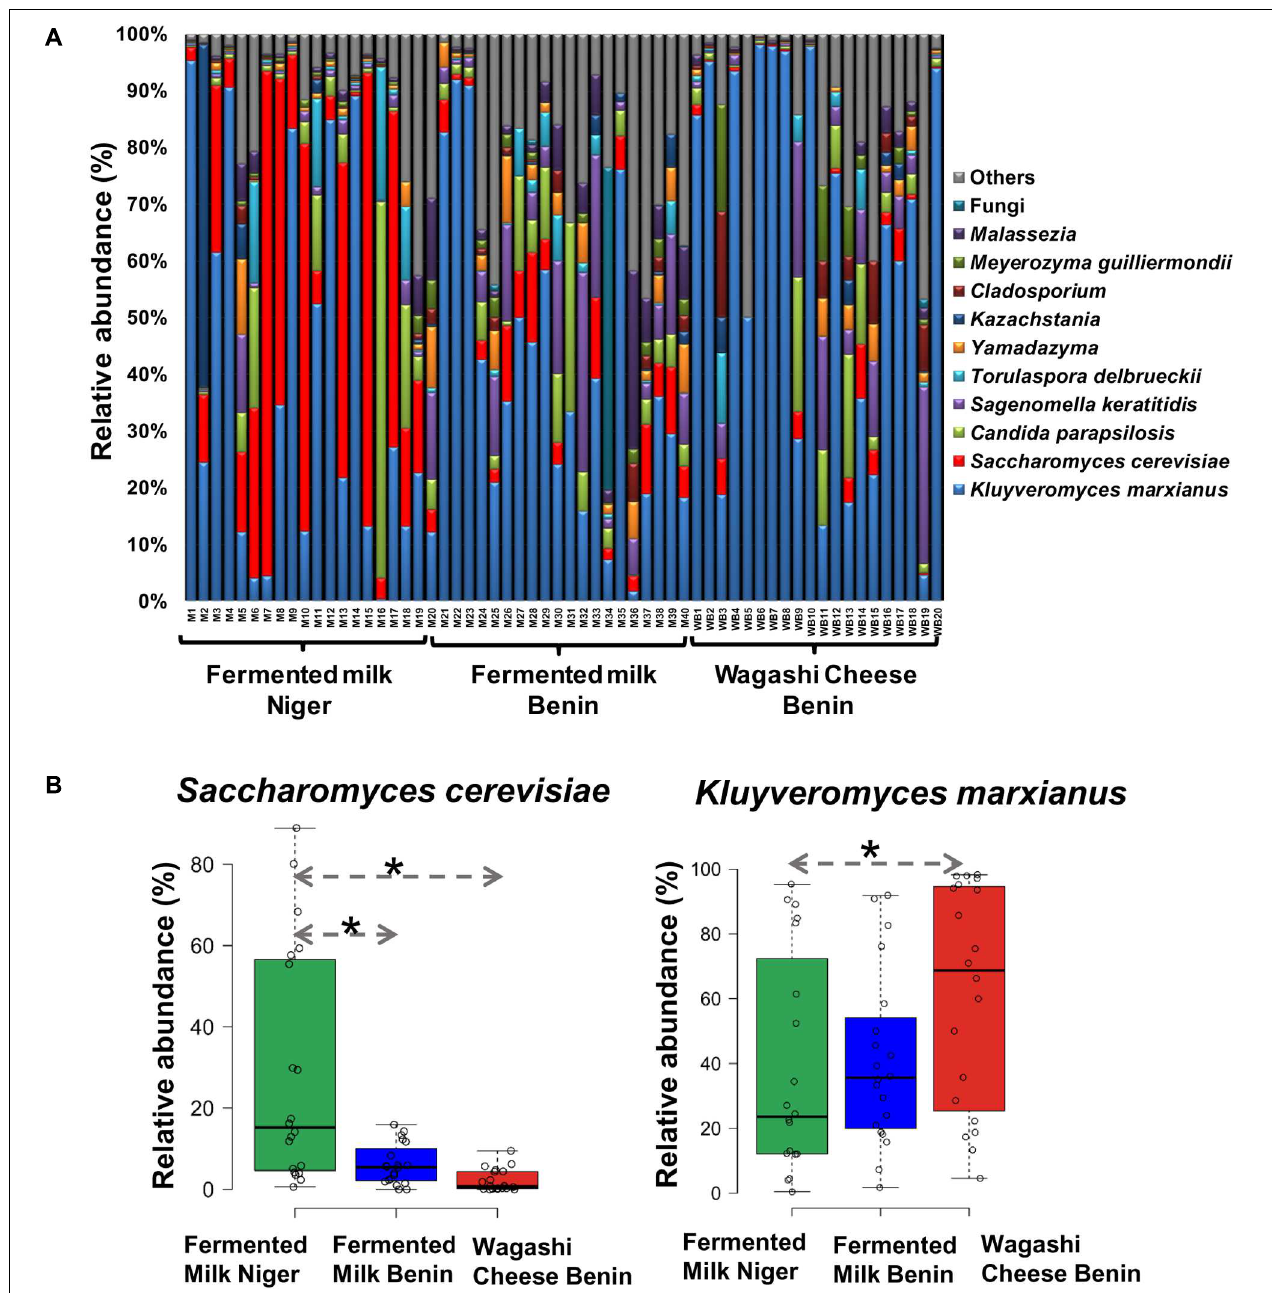
FIGURE 3 | (A) Yeast taxon plot shows the relative abundance of predominant yeast present in the naturally fermented milk products of Benin and Niger. Each column represents the relative abundance (%) of yeast taxa investigated by using Illumina MiSeq amplicon sequencing of ITS region. OTUs with similar species-level identity at 97% similarity in the UNITE database are merged here. Taxa with less than 1% mean relative abundance across the samples studied are combined and shown as others. (B) Boxplot shows the differential abundance of Saccharomyces cerevisiae and Kluyveromyces marxianus among the fermented milk products of Niger and Benin. The significance in difference was calculated by Wilcoxon test with Bonferroni correction and indicated as ∗ q <